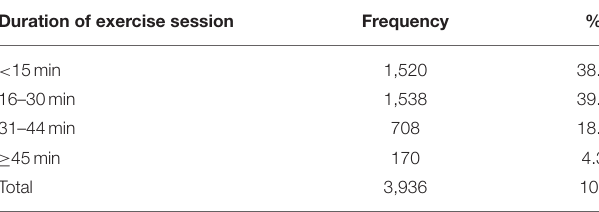
TABLE 2 | Duration of an individual session of PE during lockdown. Duration of exercise